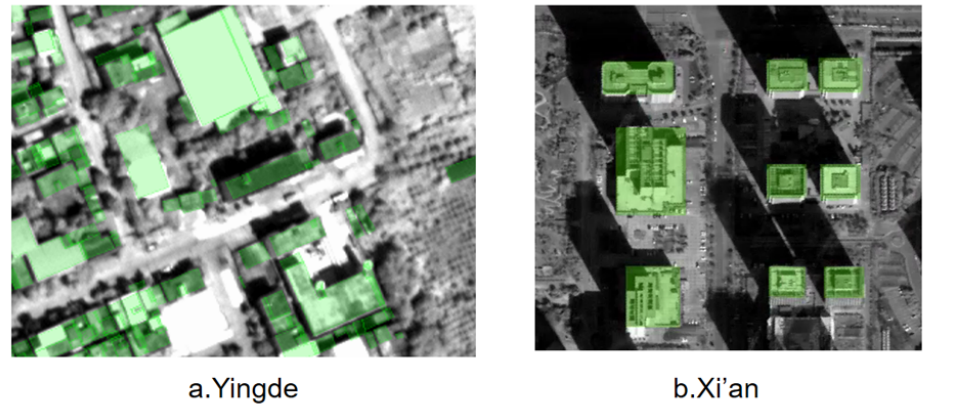
Figure 14. Self-annotated building roof contours on the GF-7 backward image. ( a ) the building roof contours in Yingde; ( b ) the countours in